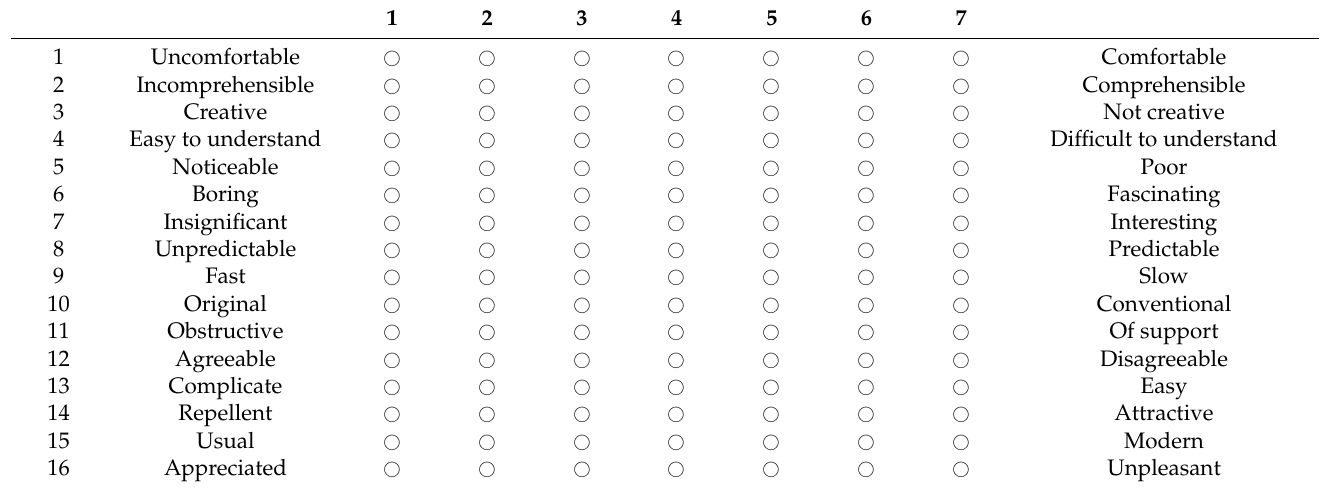
Table 3. All 26 items of the UEQ.